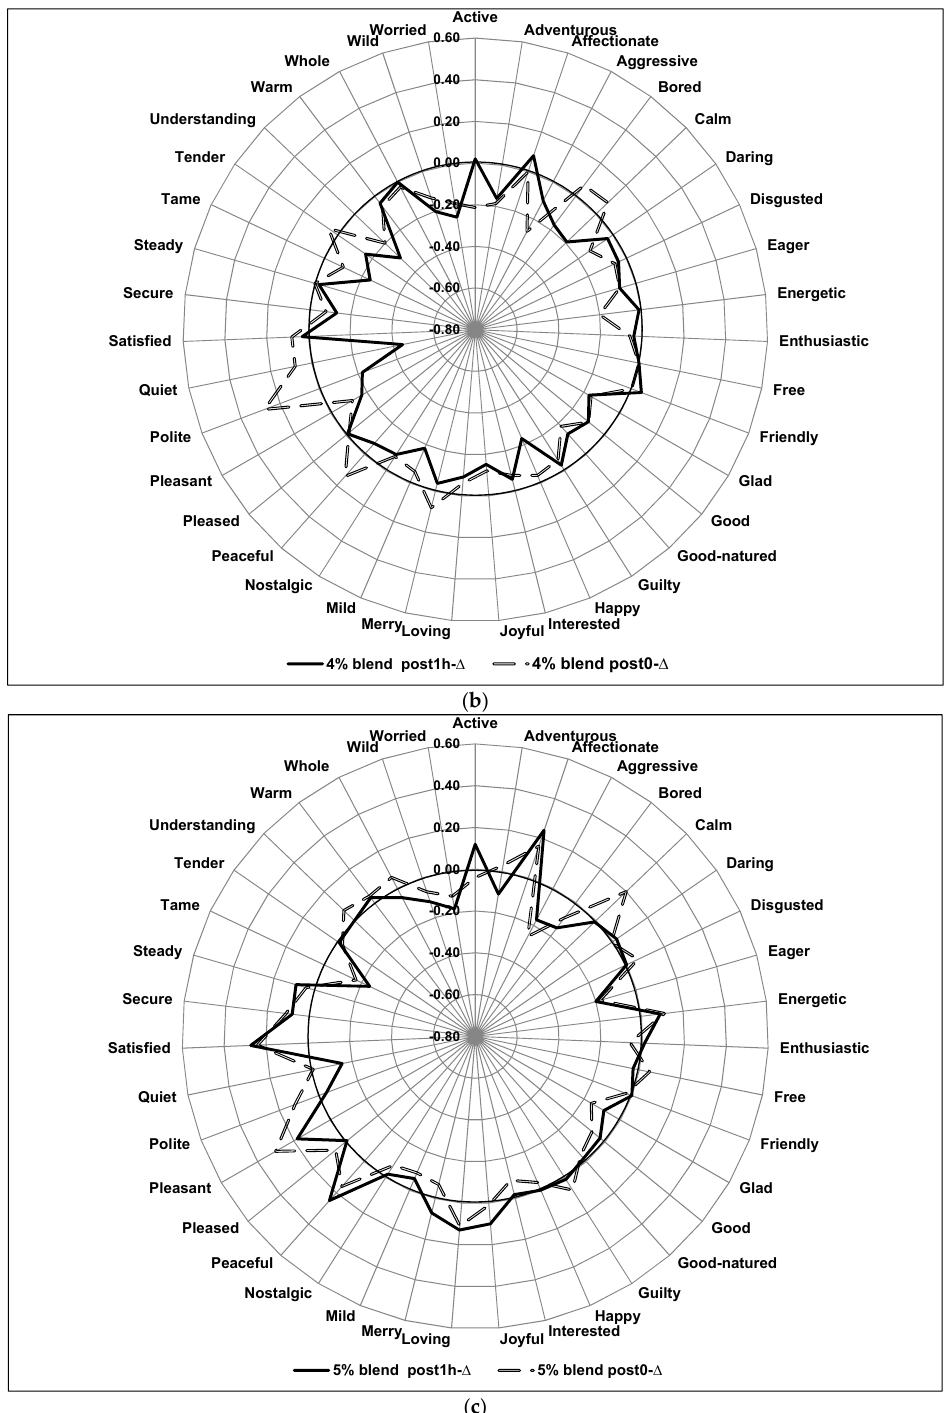
Figure 2. ( a ) Emotion intensity changes over time for each individual product: Control. ( b ) Emotion intensity changes over time for each individual product: 4% Blend. ( c ) Emotion intensity changes over time for each individual product: 5% Blend. Legend—Post0 ‐∆ = immediate ‐ post consumption—pre consumption; Post1h ‐∆ = one ‐ hour post consumption—pre consumption.